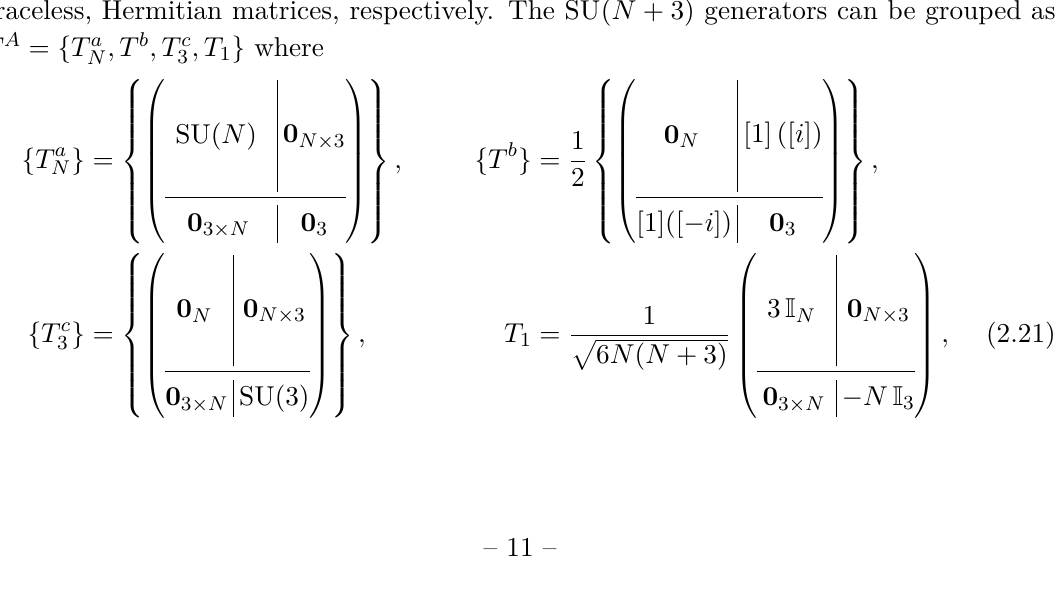
Figure 2. The enlarged color phase diagram, where ζ ∆ = κ ∆ Λ 2 are dimensionless four-fermion couplings of ∆ and R